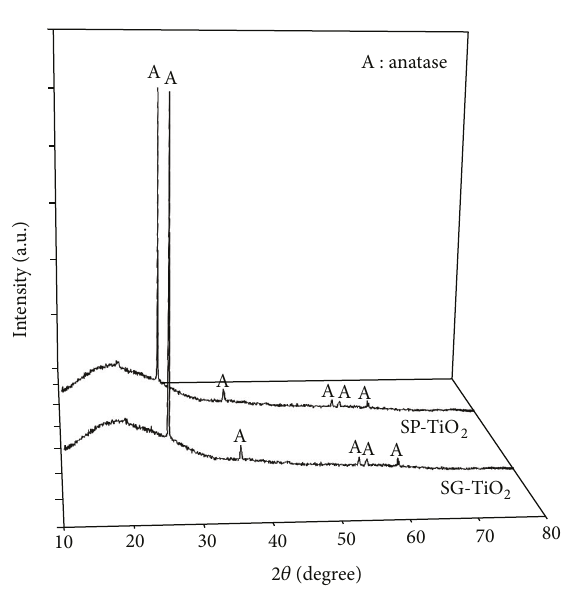
Figure 4: XRD patterns of the SG-TiO